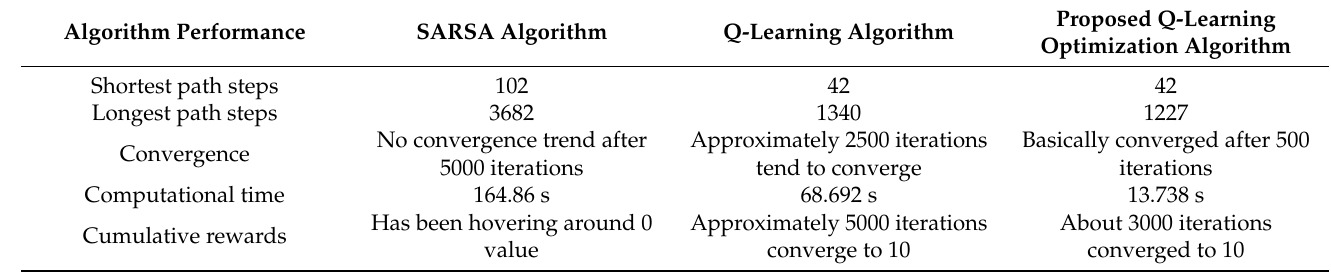
Table 2. Performance comparison of the three Figure 7. Change graph of cumulative rewards during training. ( a ) Cumulative reward of the SARSA algorithm; ( b ) Cumulative reward of the Q-learning algorithm; ( c ) Cumulative reward of the proposed Q-learning optimization algorithm.